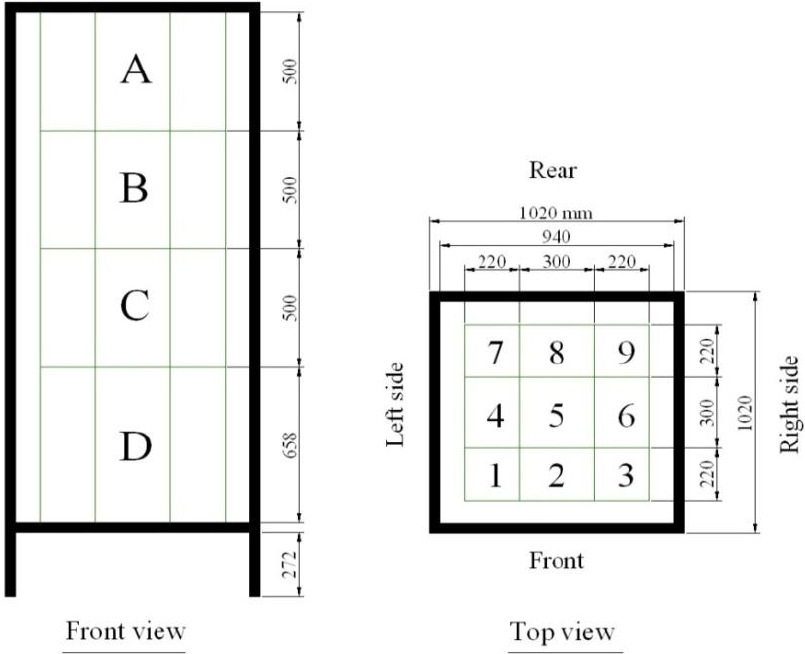
Figure 6. Front and top view of the internal division of the reference structure, together with the dimensions in mm and nomenclature.